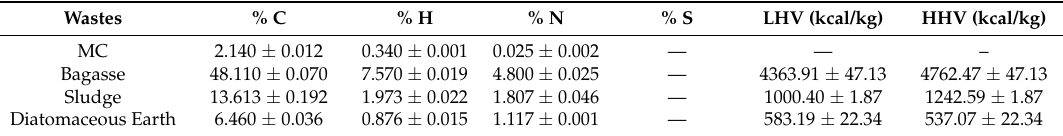
Table 2. Total content C, H, H and S of raw